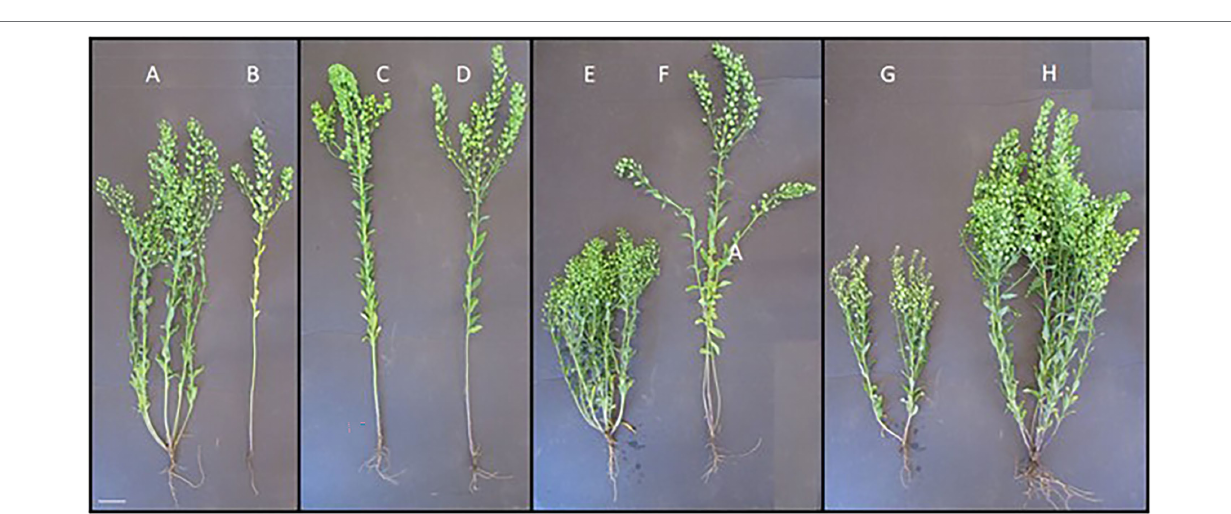
FIGURE 7 | Trait variation in pennycress. (A) Wild type, (B) non-tillering, (C) Fasciated, (D) wild type, (E) dwarfing, (F) wild type, (G) glucosinolate null, and (H) wild